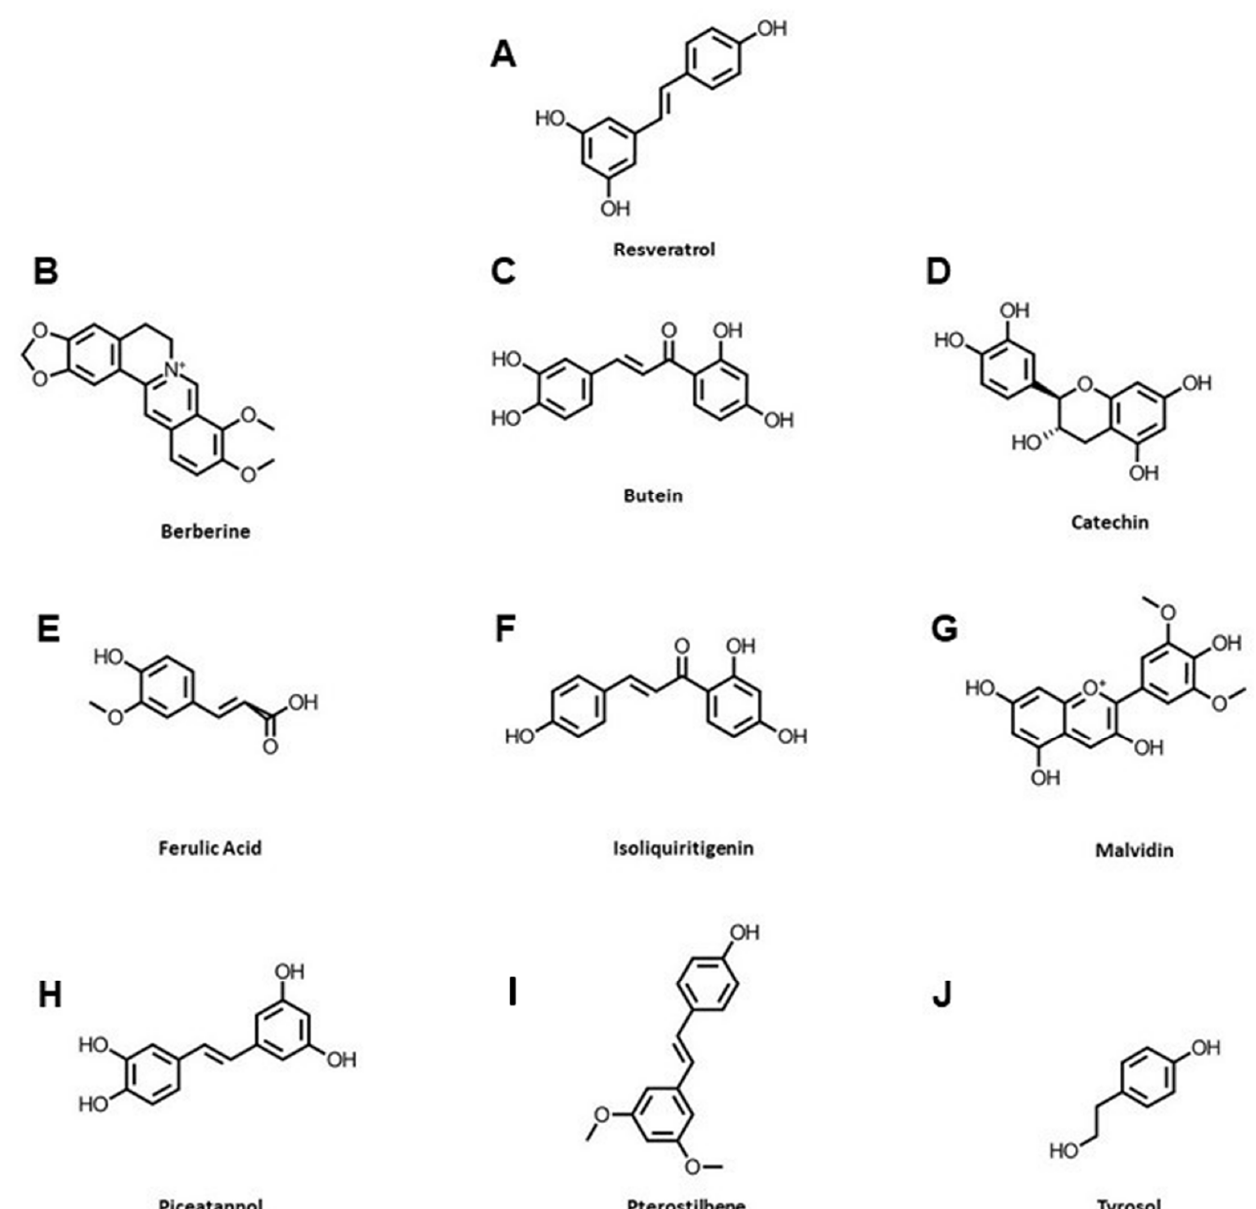
Figure 1. Chemical structures of phenolic compounds used in this study. Resveratrol is mainly found in grapes and berries ( A ), Berberine in barberry fruits and turmeric ( B ), Butein in broad beans ( C ), Catechin in green tea, cocoa, and apricots ( D ), Ferulic acid in cereals such as rice, wheat, and oats ( E ), Isoliquiritigenin in liquorice ( F ), Malvidin ( G ), Piceatannol ( H ), and Pterostilbene ( I ) in grapes and blueberries, and Tyrosol in olives and grapes ( J ).